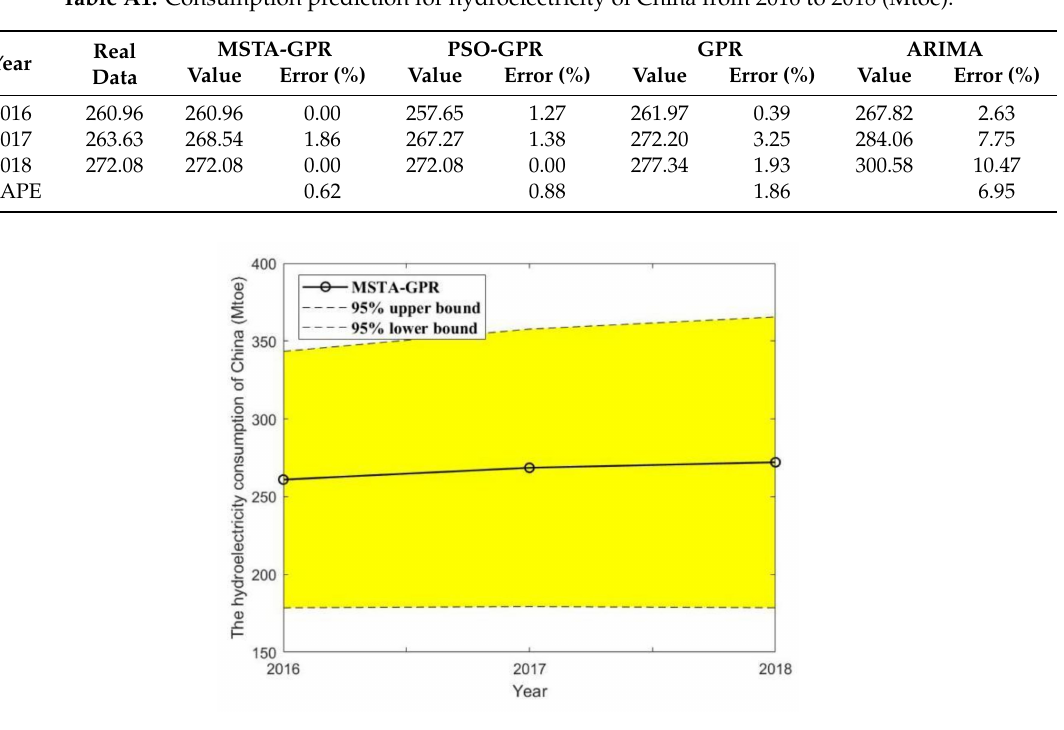
Figure A1. The interval prediction result of MSTA-GPR for China’s hydroelectricity